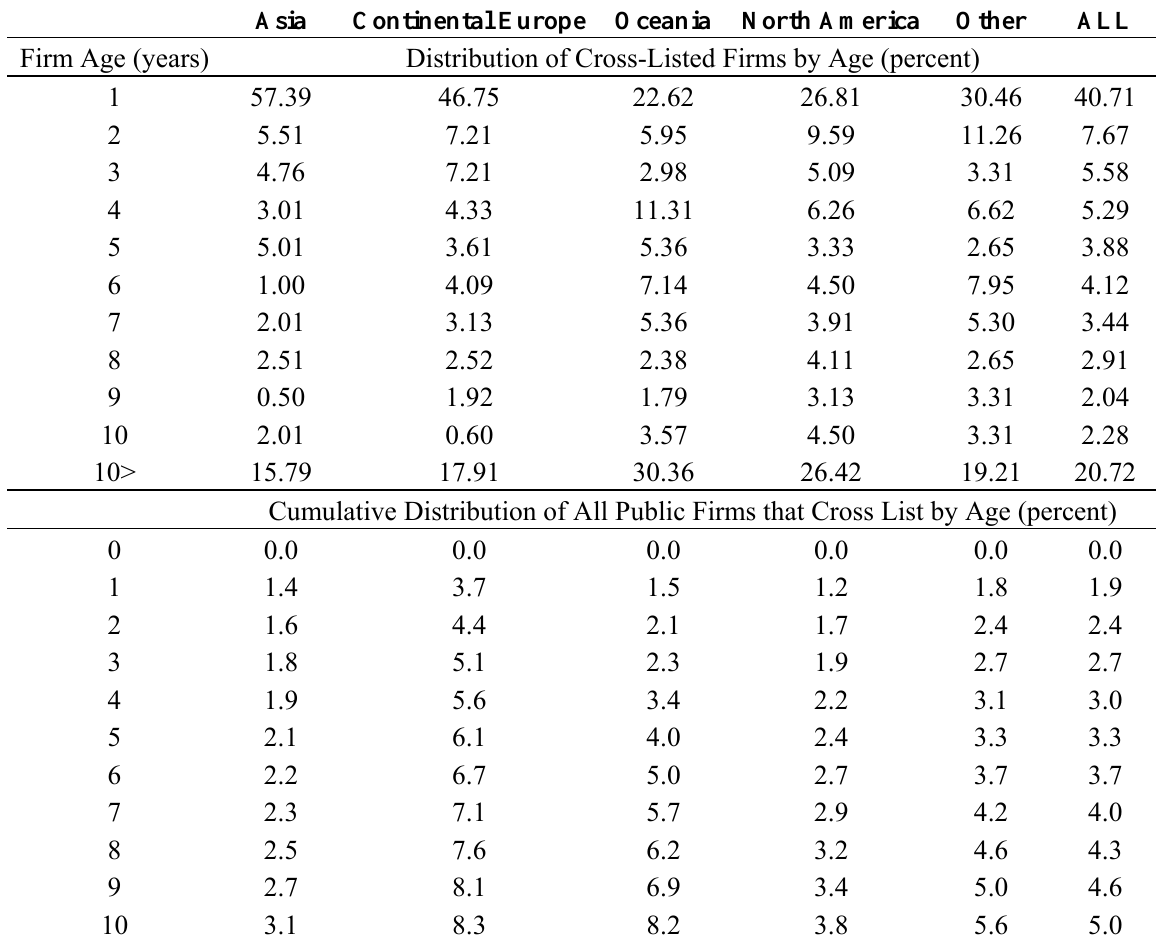
Table 3. Cross-Listing Activities of U.S. and Overseas Public Companies. Asia Continental Europe Oceania North America Other ALL Firm Age (years) Distribution of Cross-Listed Firms by Age